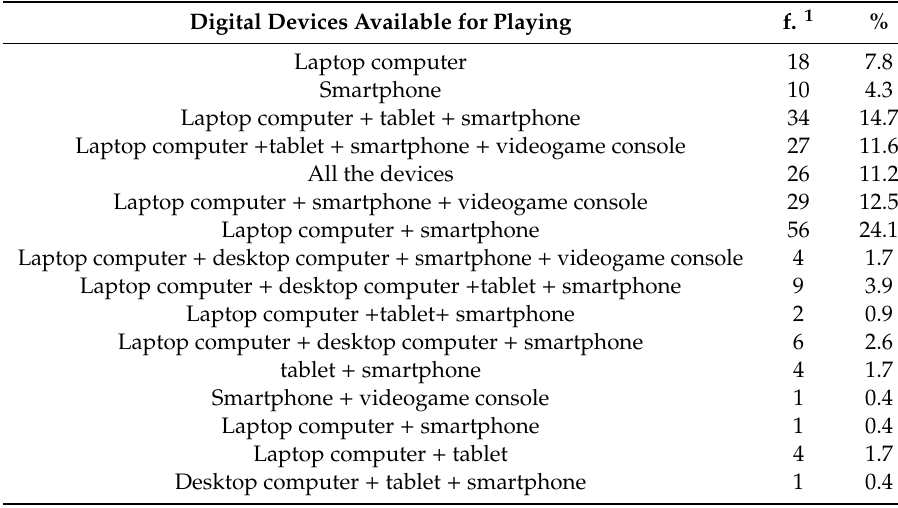
Table 2. Digital devices available for playing. Digital Devices Available for